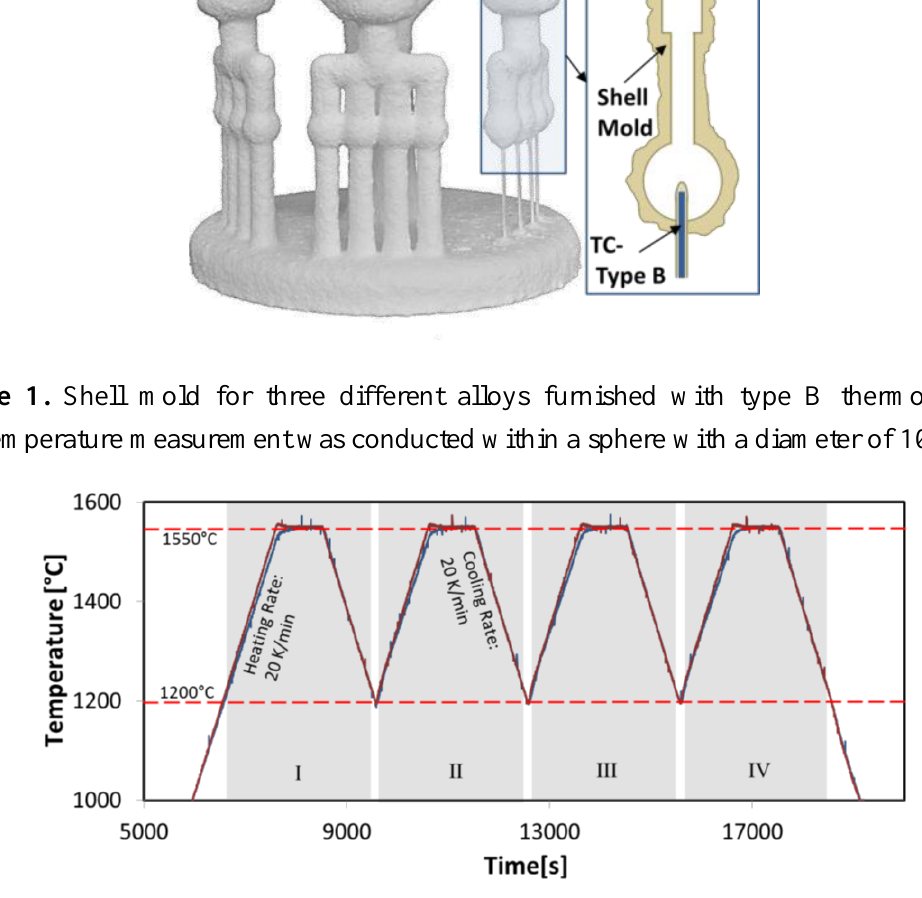
Figure 2. Temperature program for the resistance heater in the vacuum